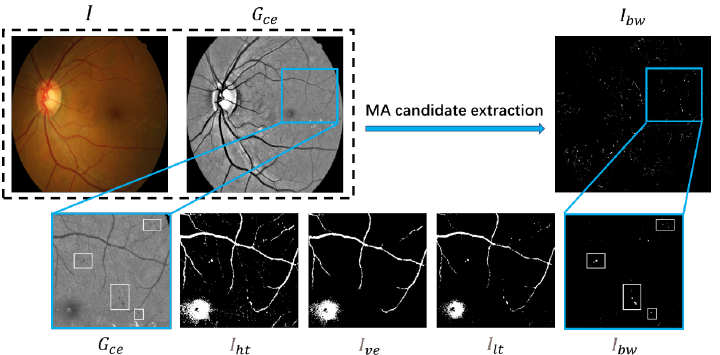
Figure 4. An example to illustrate the candidate extraction method. From top to bottom and left to right: original image I , the green channel of the preprocessed image G ce , the binary mask of candidate area I bw , details in the green channel of the preprocessed image I ce , the first binary image I ht under a higher threshold, the vessels mask I ve , the second binary image I lt under a lower threshold, and the binary mask of candidate area I bw . The areas with MAs are identified with white